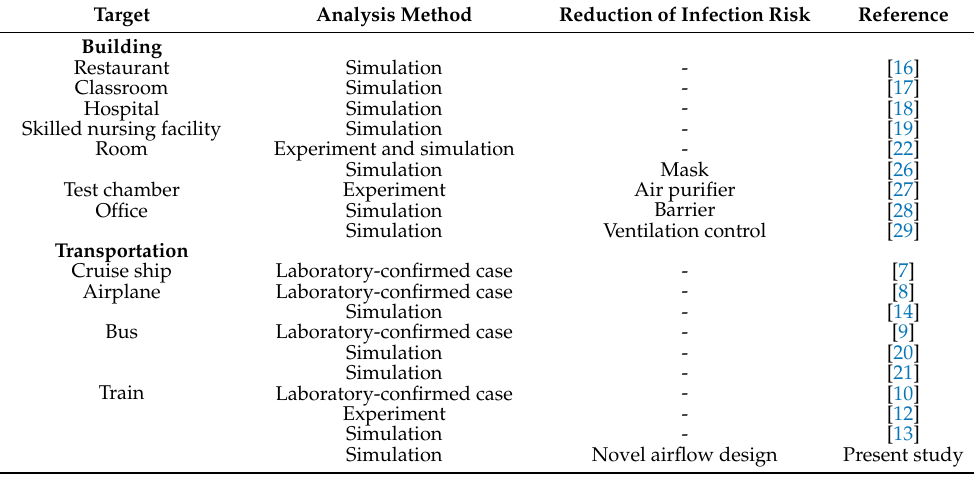
Table 1. Previous studies on droplet transmission and reduction of infection risk.